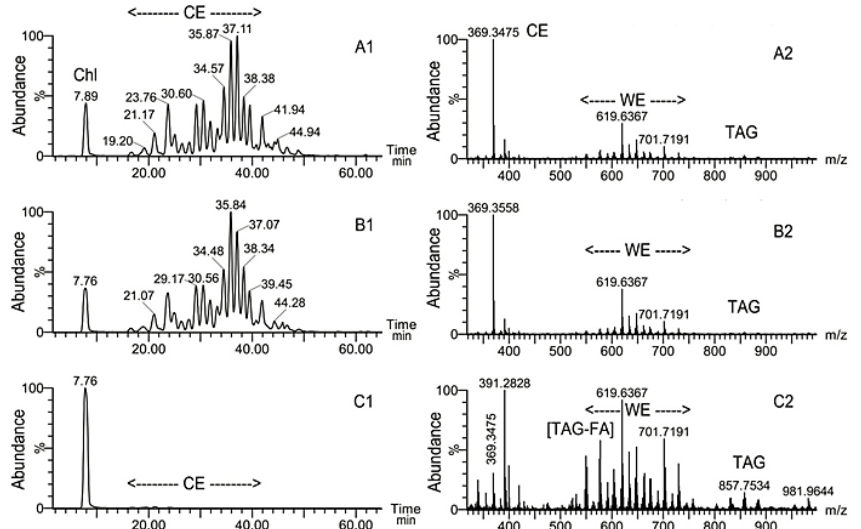
Figure 3. Effects of Soat1 inactivation on Meibomian lipid profiles of mice. Panels A1 , B1 , C1 : Ex- tracted ion chromatograms of free Chl and CE detected as an ion with m/z 369.35; Panels A2 , B2 , C2 : observation mass spectra of the samples. A1 , A2 —wild-type mouse; B1 , B2 —heterozygous mouse; C1 , C2 —homozygous mouse. Peak m/z 391.2828—unknown.